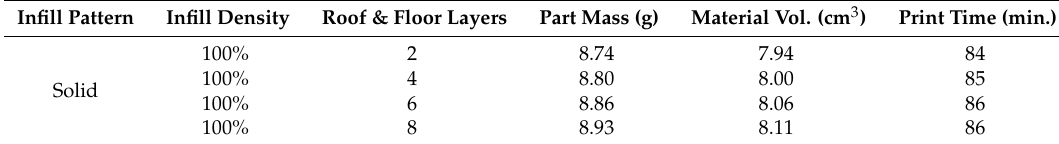
Table 3. Nylon substrates information from Eiger for Research Question